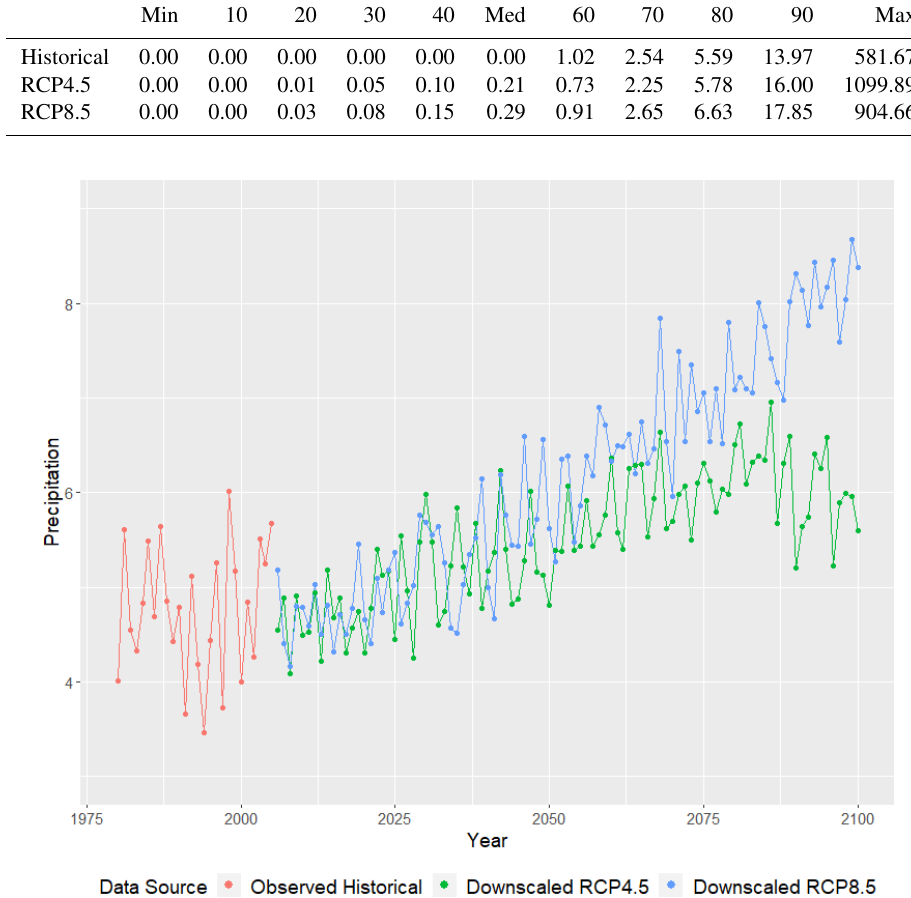
Figure 13. Observed historical (GHCN) daily mean precipitation (mm) data from 1980–2005 are plotted in red, while CanESM2 RCP4.5 and RCP8.5 downscaled mean precipitation data from 2006–2100 are plotted in green and blue, respectively. This figure was created using Wickham